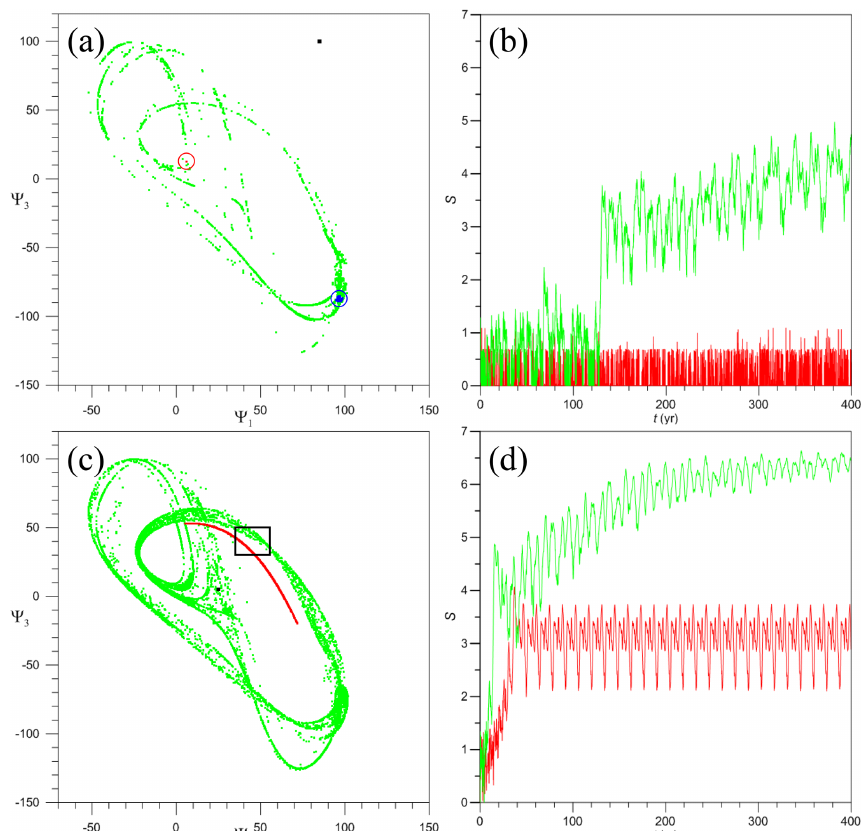
Figure 4. Chaotic and nonchaotic behavior of the autonomous model, for time-independent forcing intensity γ = 1 . 1 (red) and γ = 1 . 35 (green), respectively. Typical behavior of (a, c) the trajectories in the model’s phase plane ((cid:57) 1 ,(cid:57) 3 ) and (b, d) of the model’s entropy S ϑ (t) . (a) Intersection with the ((cid:57) 1 ,(cid:57) 3 ) plane at t = 300 years of 15000 trajectories emanating from the small square box ϑ 1 of width (cid:49)(cid:57) = 2 and centered at the point P 1 (black dot), for γ = 1 . 1 (red dots, enclosed in the red circle) and for γ = 1 . 35 (green dots); for the blue dots see the text. (b) Time evolution of the corresponding entropy S ϑ for γ = 1 . 1 (red line) and γ = 1 . 35 (green line). (c, d) Same as panels (a) 1 and (b) , but for the initial box ϑ 2 centered at P 2 , likewise shown as a black dot in panel (c) . For the evolution of the points contained at t = 300 years in the black rectangle of panel (c) , see Fig. 5 below.